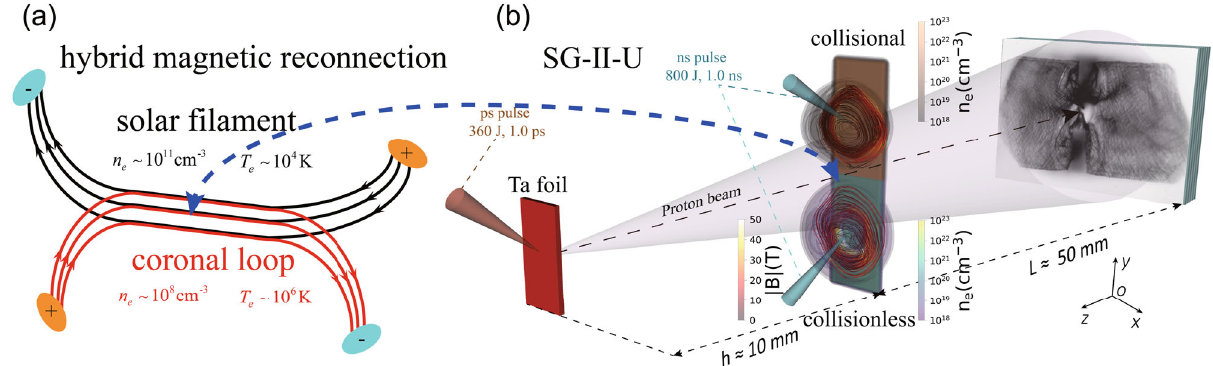
Fig. 1 Hybrid collisional-collisionless magnetic reconnection con fi gurations and experimental set-up. a Magnetic reconnection in the hybrid regime between the collisional solar fi laments and the nearby collisionless coronal loops. b Setup for the experiment on magnetic reconnection in the hybrid collisional-collisionless regime, which is achieved by irradiation of Cu (yellow) and CH (C 1 H 1 , green) foil targets respectively with long ns laser pulses synchronously. Proton radiography is set up along the face-on ( − z -axis) direction for probing the magnetic fi eld topology changes during the reconnection process, where the high-quality proton beam is generated from a tantalum foil target driven by the relativistic ps laser pulse, see